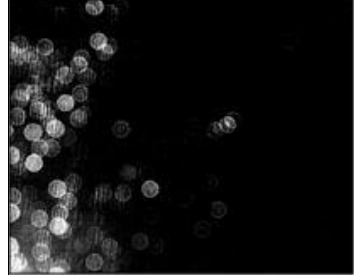
Fig. 11. Interferogram obtained by experimental IPI method.